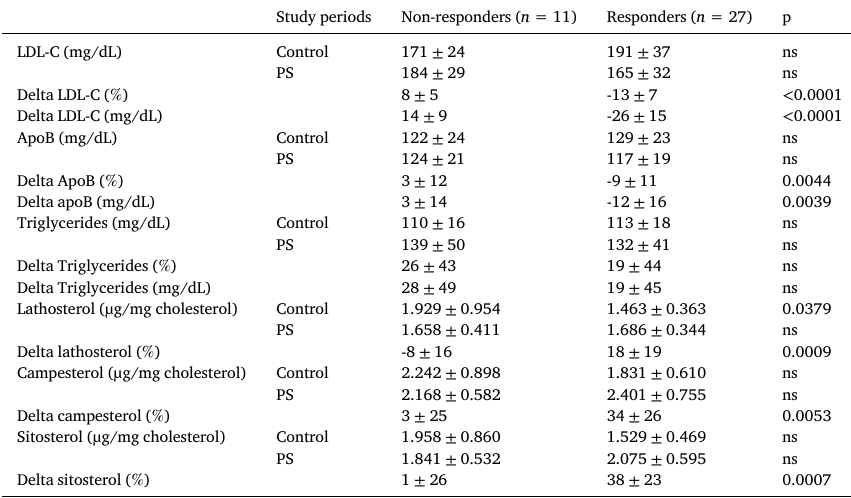
Table 5 Plasma sterol response patterns de fi ned by LDL-C changes distinguish patients ' non-responders and responders to PS